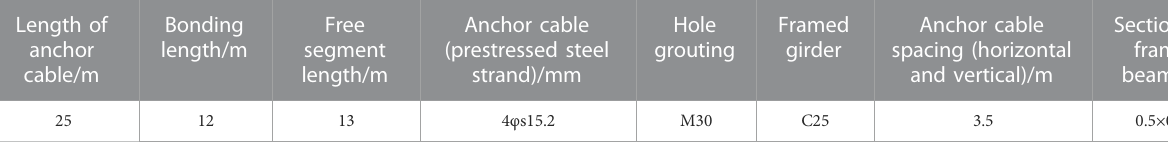
TABLE 1 Setting Information of prestressed anchor cable frame beam.